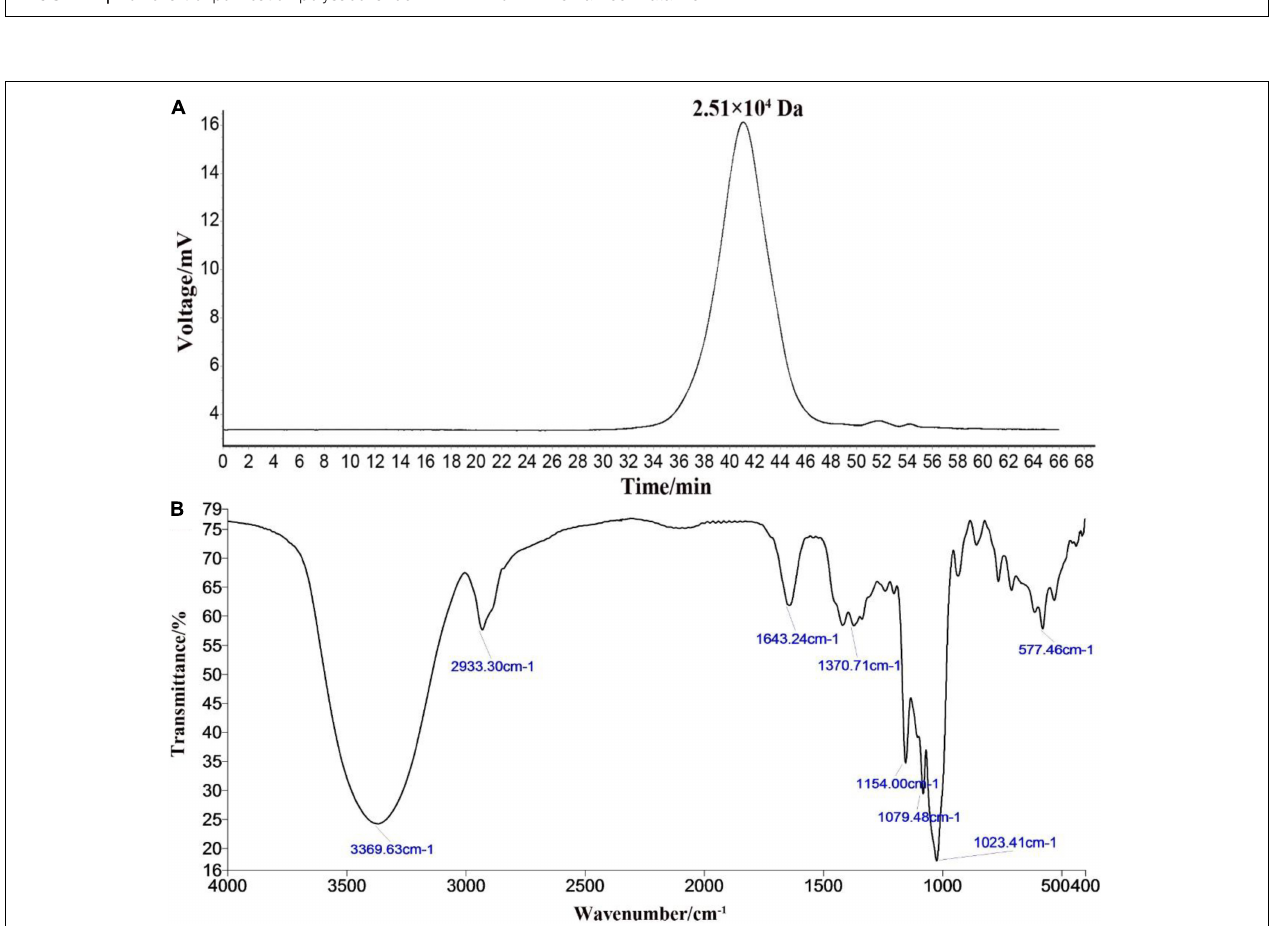
FIGURE 2 | High-performance gel permeation chromatography spectra (A) and infrared spectra (B) of RATAPW.